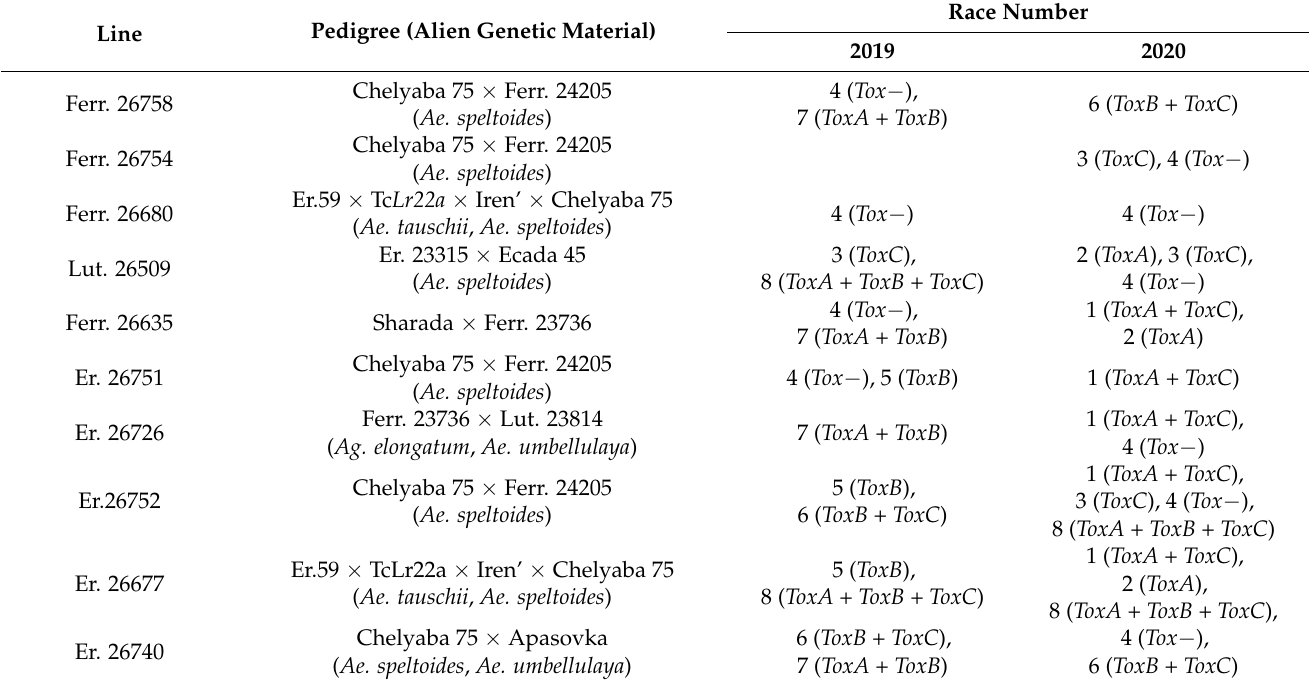
Table 5. Races of Pyrenophora tritici-repentis on introgressive soft wheat breeding lines in 2019–2020 in Chelyabinsk region